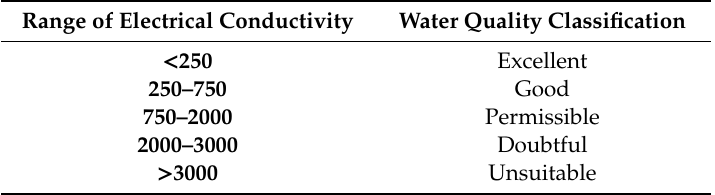
Table 5. Water quality classification for various ranges of EC in µ S / cm